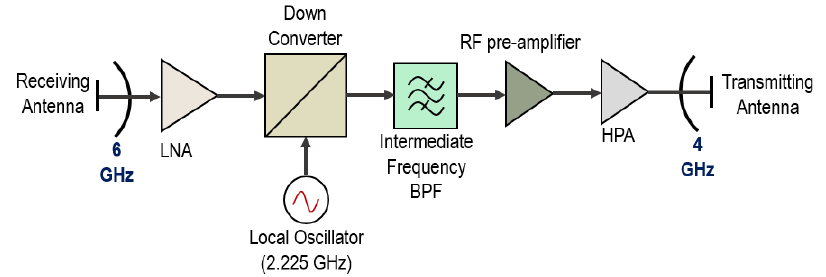
Figure 2. Block diagram of the transponder for 6/4 GHz.